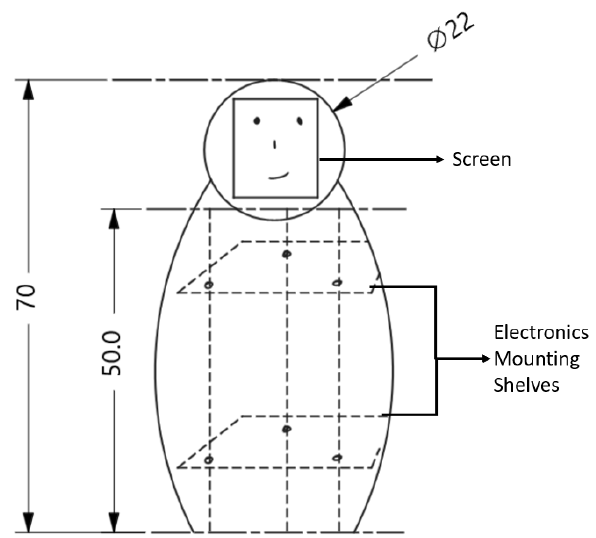
Figure 3. Socially Assistive Robot (SAR) design sketch. The total height will be ~70 cm, so that it is around chest height when placed on a table. This design is non-motile, with an LED-screen face on the robot’s head that doubles as a touch-screen for certain interactions. Electronics will be housed in the torso region ~50 cm tall.